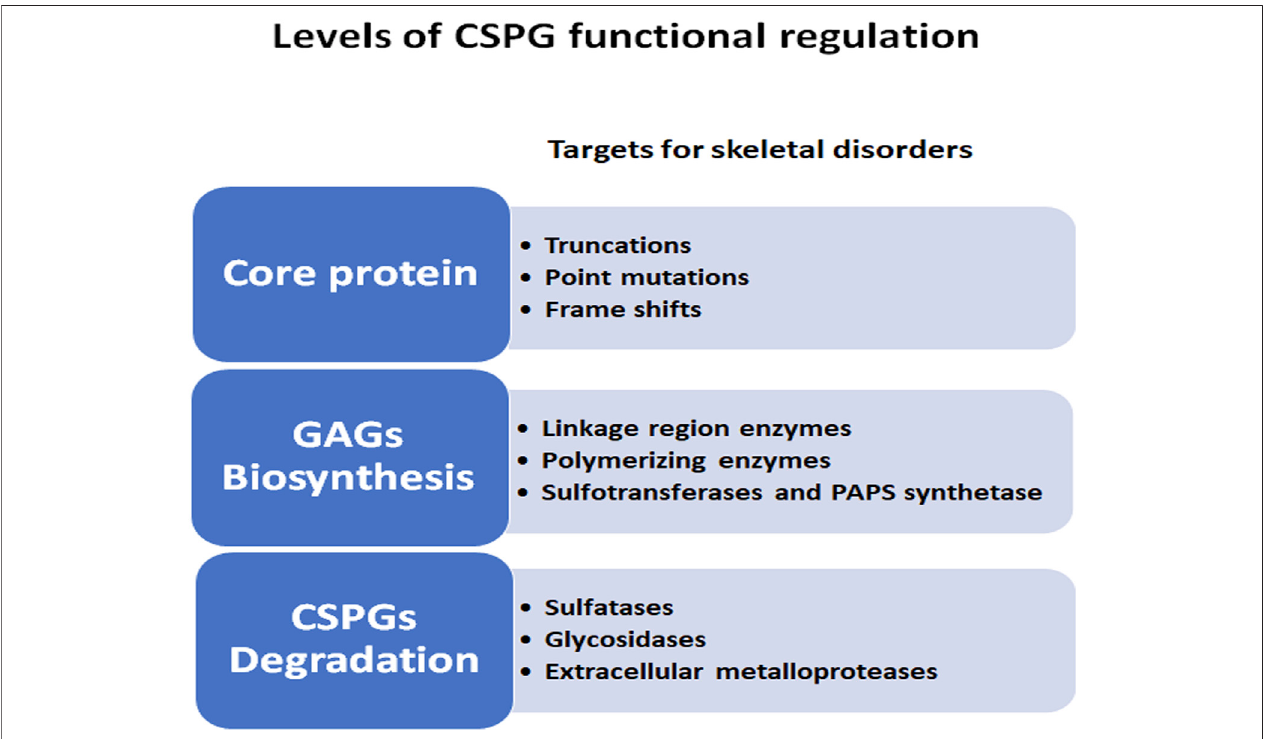
FIGURE 2 | Levels of CSPG functional regulations during skeletal development. CSPG complexity is illustrated by the multiple levels at which the synthesis and degradation of these molecules can affect the outcome of normal growth plate development.